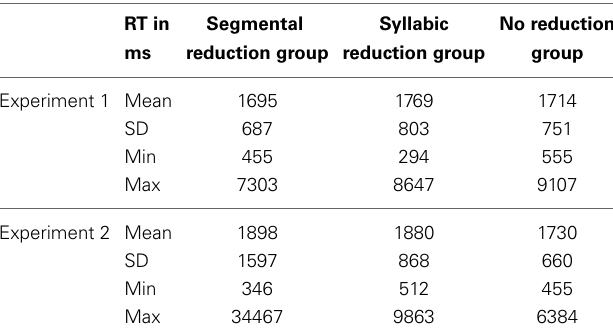
Table 2 | RTs in ms in the test phases of Experiments 1 and 2 for clicks on targets and